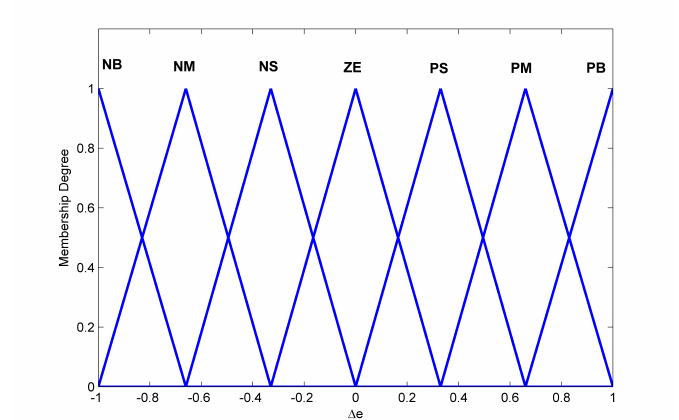
Figure 6. Input variable of fuzzy controller-change in error ( ∆ e